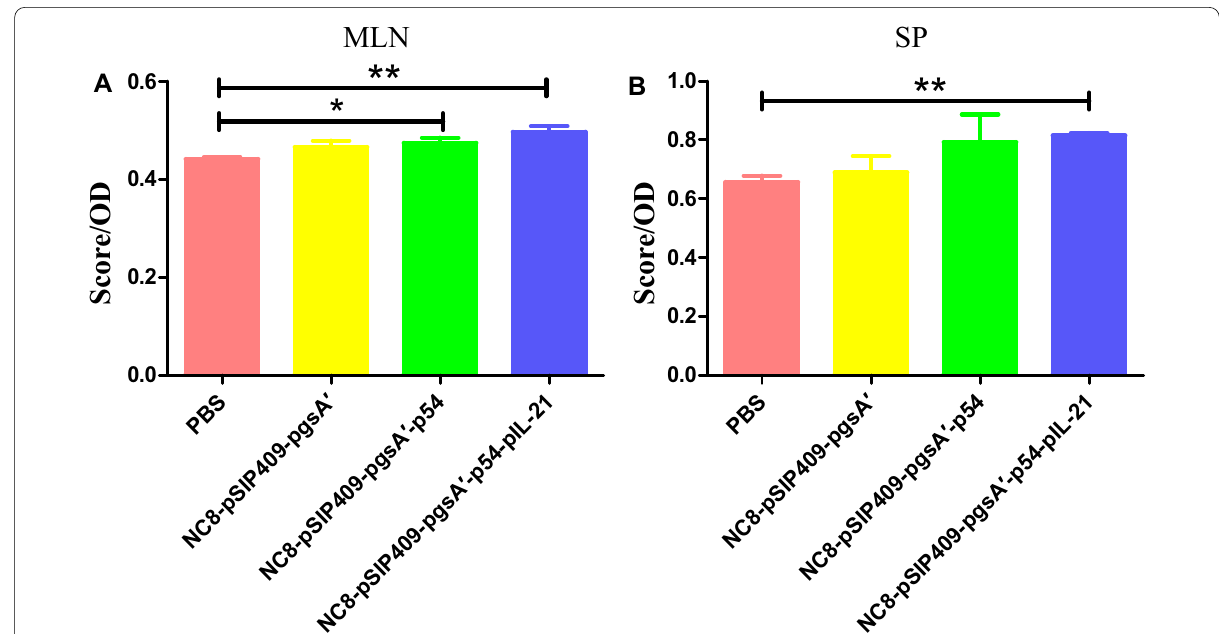
Fig. 5 A The results of lymphocyte proliferation in the MLN. B The results of lymphocyte proliferation in the